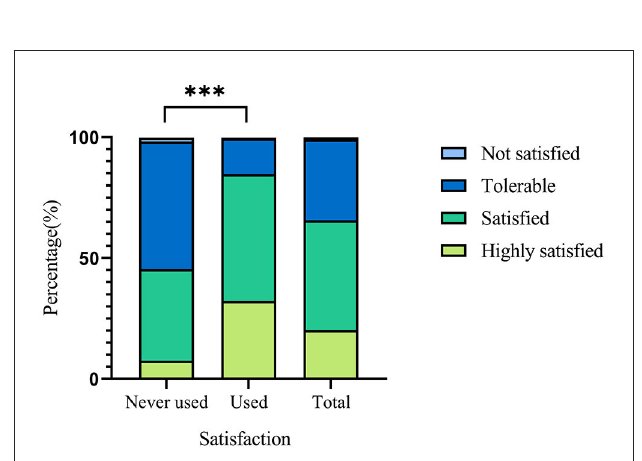
FIGURE3 Satisfaction with Internet-based healthcare services provided by primary health institutions among participants who ever used and did not. *** p -value < 0.001.